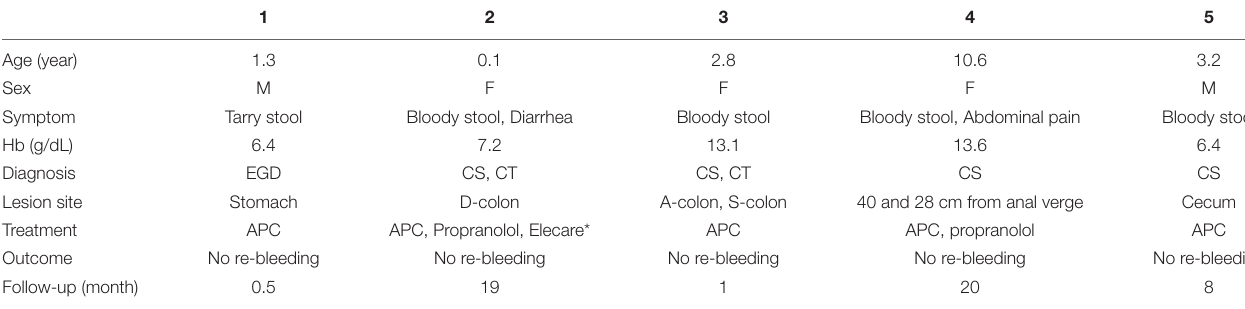
TABLE 1 | Clinical features of the five patients receiving argon plasma coagulation.